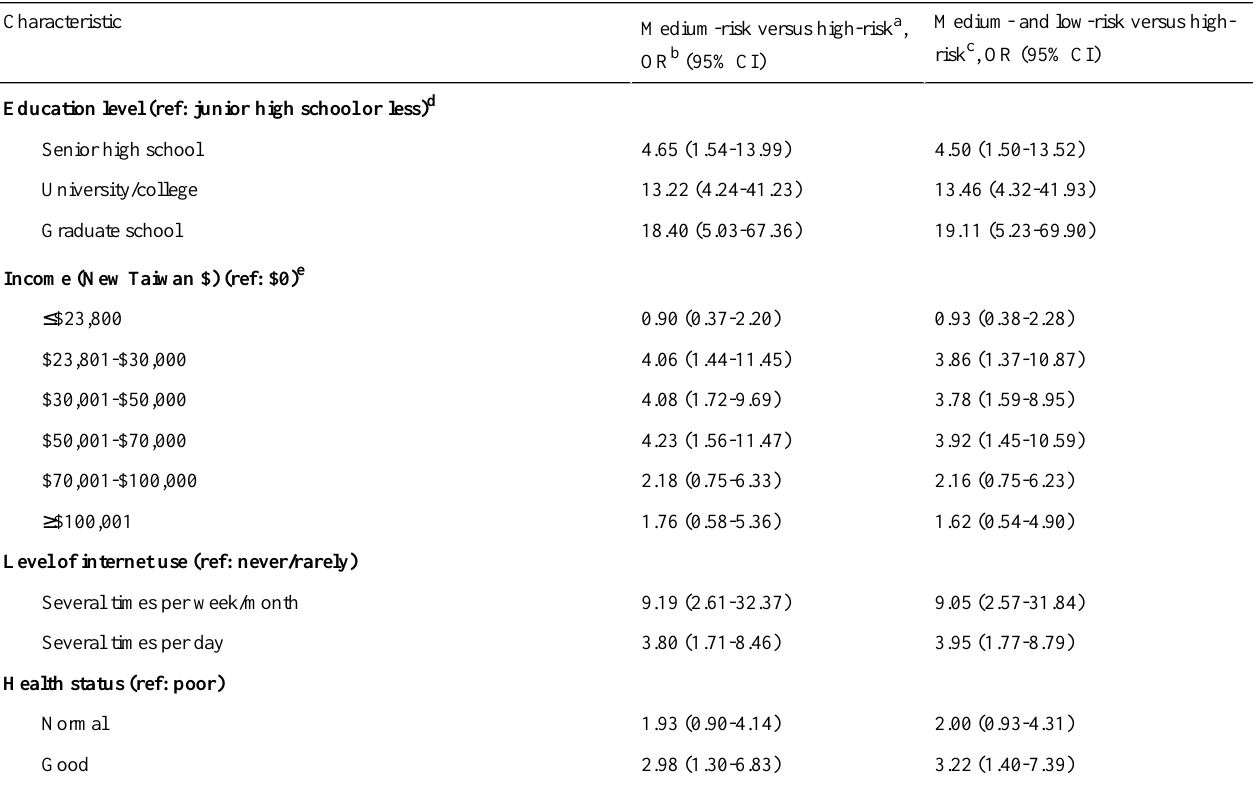
Table 6. Logistic regression analysis across different risk groups ( P <.001).